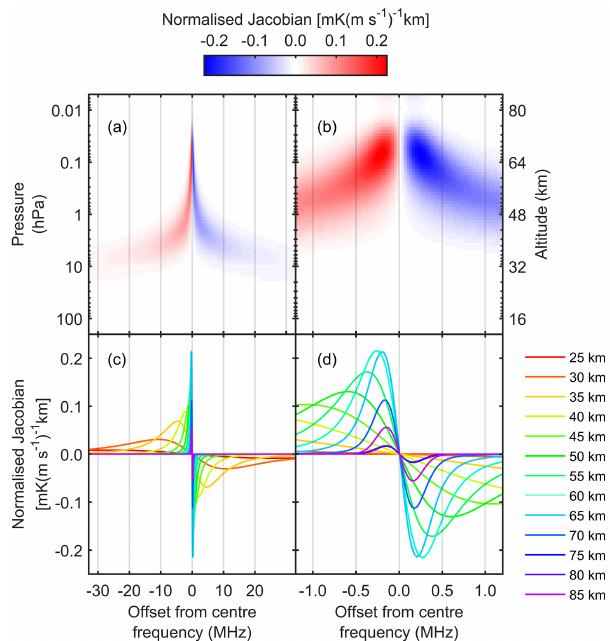
Figure 9. Rows of the Jacobian describing the horizontal wind retrieval, normalised by the layer thickness of the retrieval grid. The data are from zonal wind retrievals for simulated clear-sky, 12h observations (i.e. 6h in east and 6h in west directions) of the O 3 231.28GHz line using a ground-based radiometer with a 1400K system temperature, 30kHz frequency resolution, and 60 ◦ zenith viewing angle located at Halley station (75 ◦ 37 (cid:48) S, 26 ◦ 14 (cid:48) W), Antarctica. The colour scale in (a) and (b) indicates the values of the Jacobian matrix. Rows of the Jacobian matrix for selected altitude levels are plotted in (c) and (d) . Plots (b) and (d) show the centre frequencies on an expanded scale.